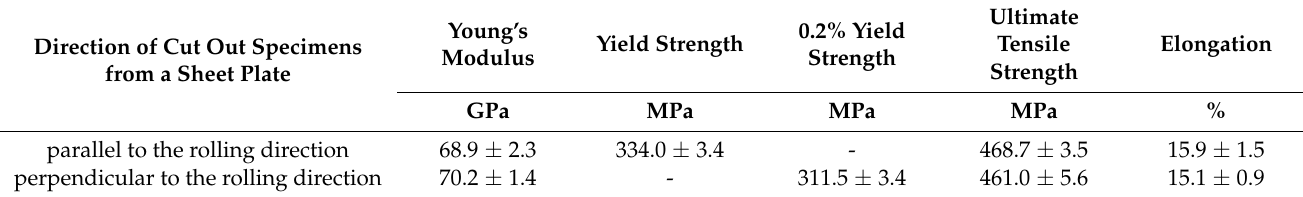
Table 5. Monotonic properties of the 2024-T3 alloy in the form of 0.05” thick sheet plate.